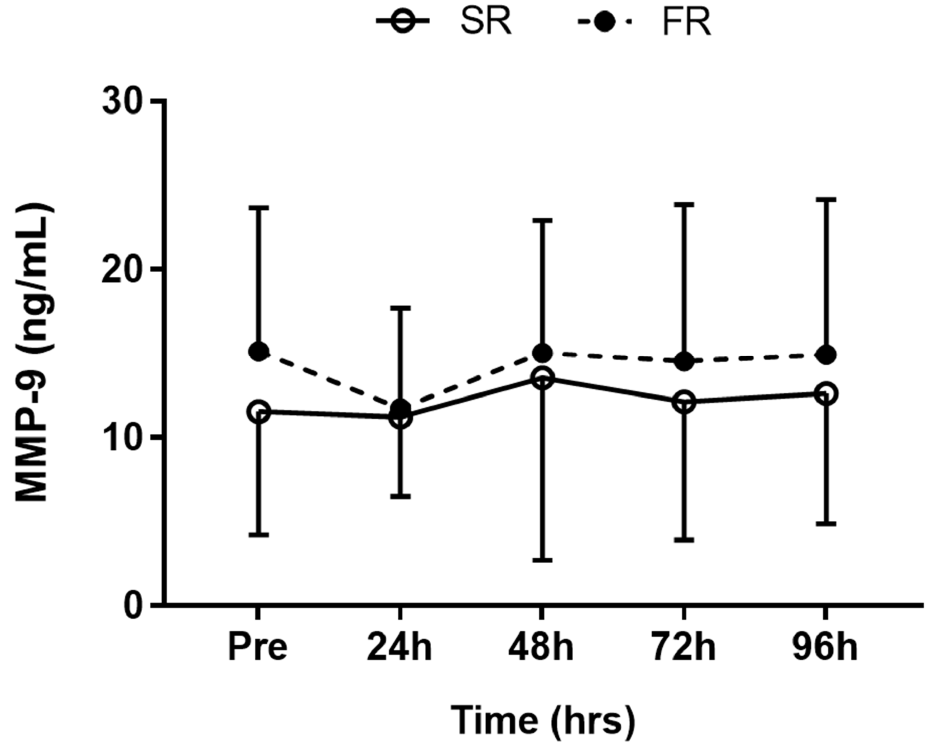
Figure 4. Changes in MMP-9 level in response to strength recovery after eccentric exercise. SR refers to subjects (n = 8) with slower recovery ( < 40%), and FR refers to subjects (n = 8) with faster recovery ( > 80%). Values are means ± SD.